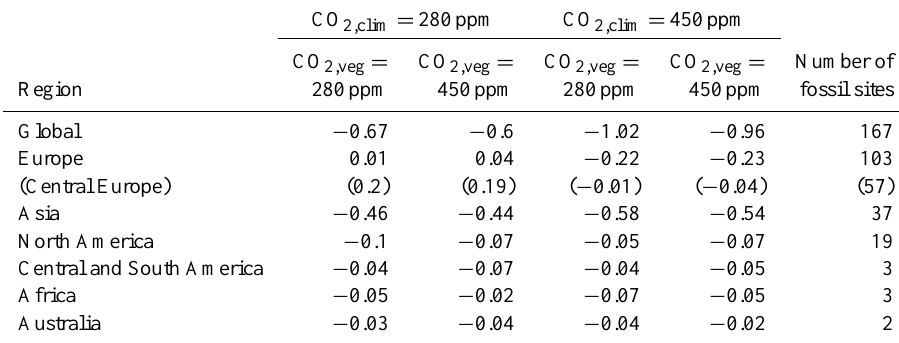
Table 2. Global and regional agreement index values from all permutations of 280 and 450ppm CO 2 concentrations in the climate model (CO 2,clim ) and vegetation model (CO 2,veg ). Central Europe is shown separately and is defined to lie in the longitude range [0 ◦ , 25 ◦ ] and latitude range [45 ◦ , 55 ◦